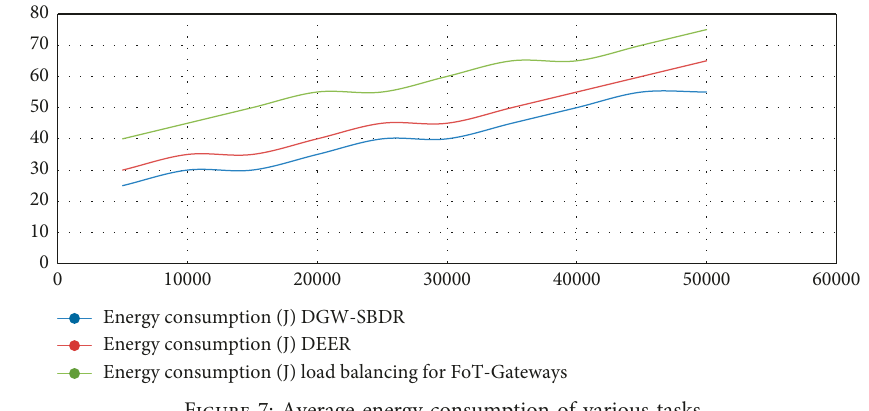
Figure 7: Average energy consumption of various tasks.